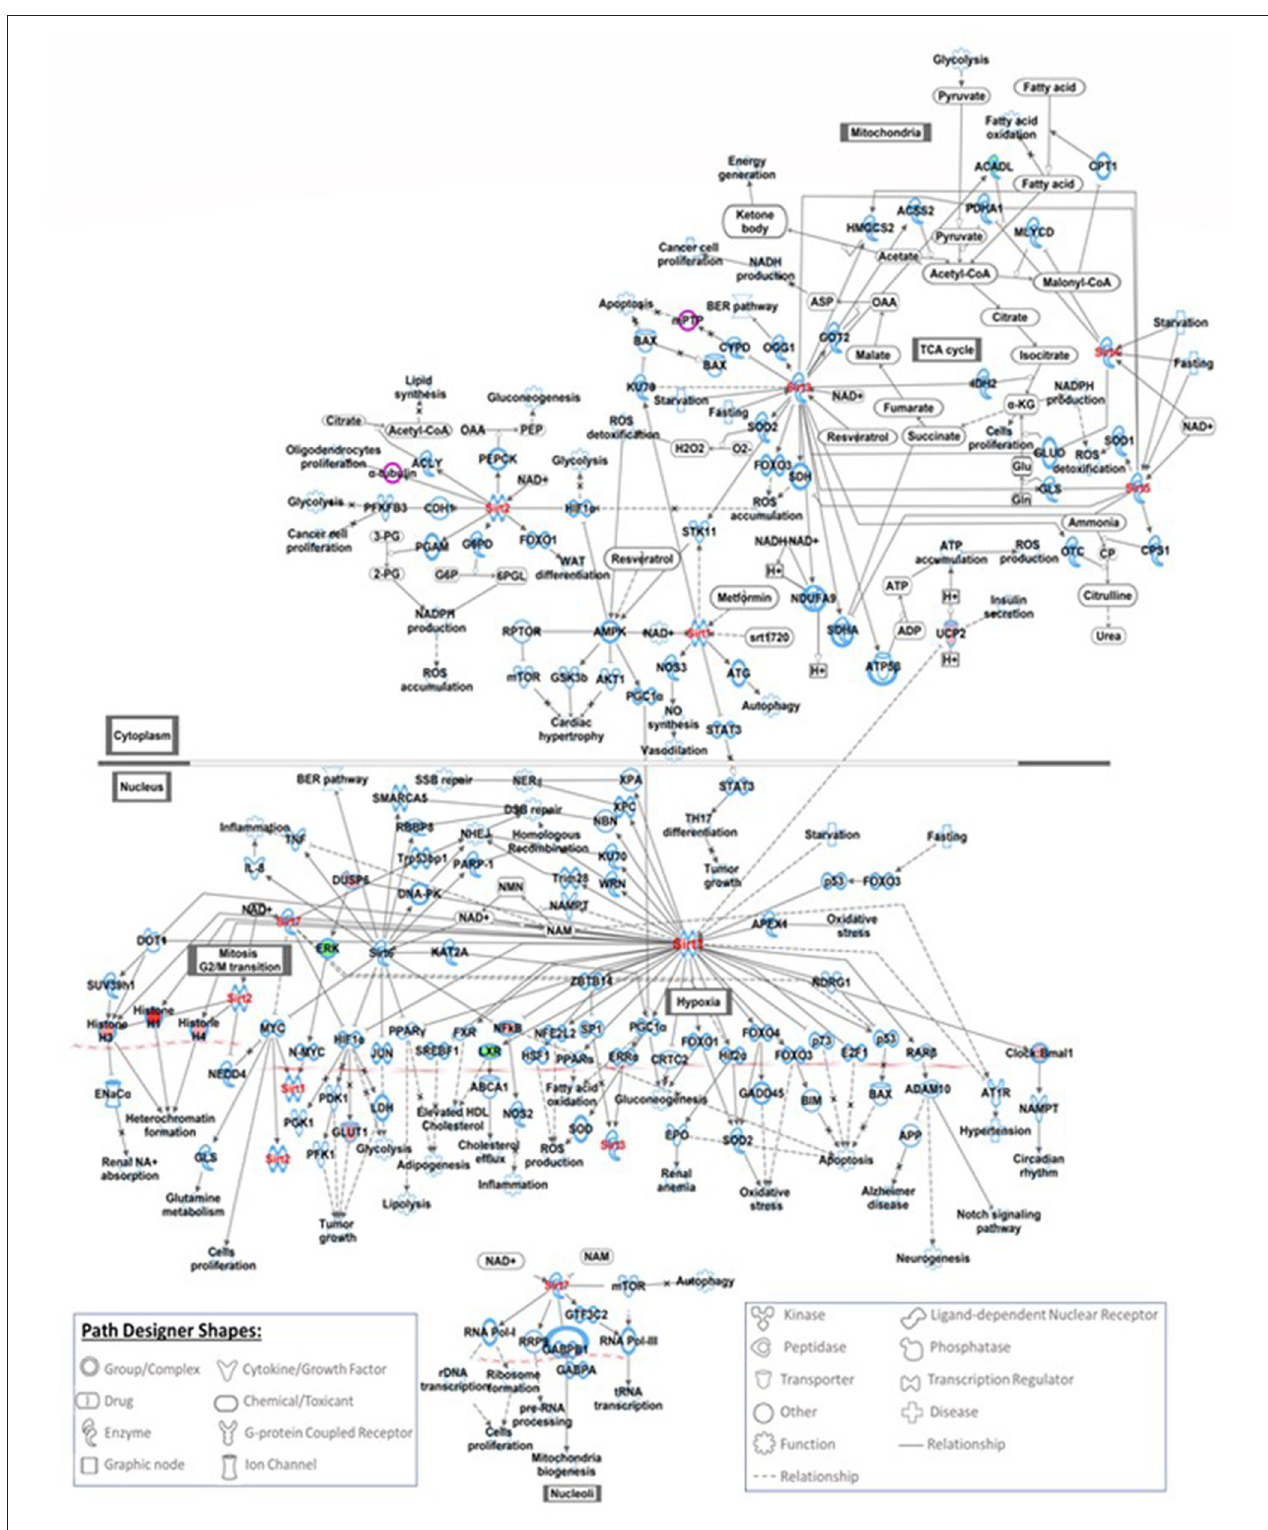
FIGURE 1 | This figure shows the IPA canonical TREM1 signaling pathway. TREM1 is an important signaling receptor that plays role in systemic infections, inflammation, neurological development and coagulation. Seven genes involved in TREM-1 signaling pathways were modified with exposure to COVID-19, red filled path designer shapes are upregulated genes and green filled path designer shapes are downregulated genes.